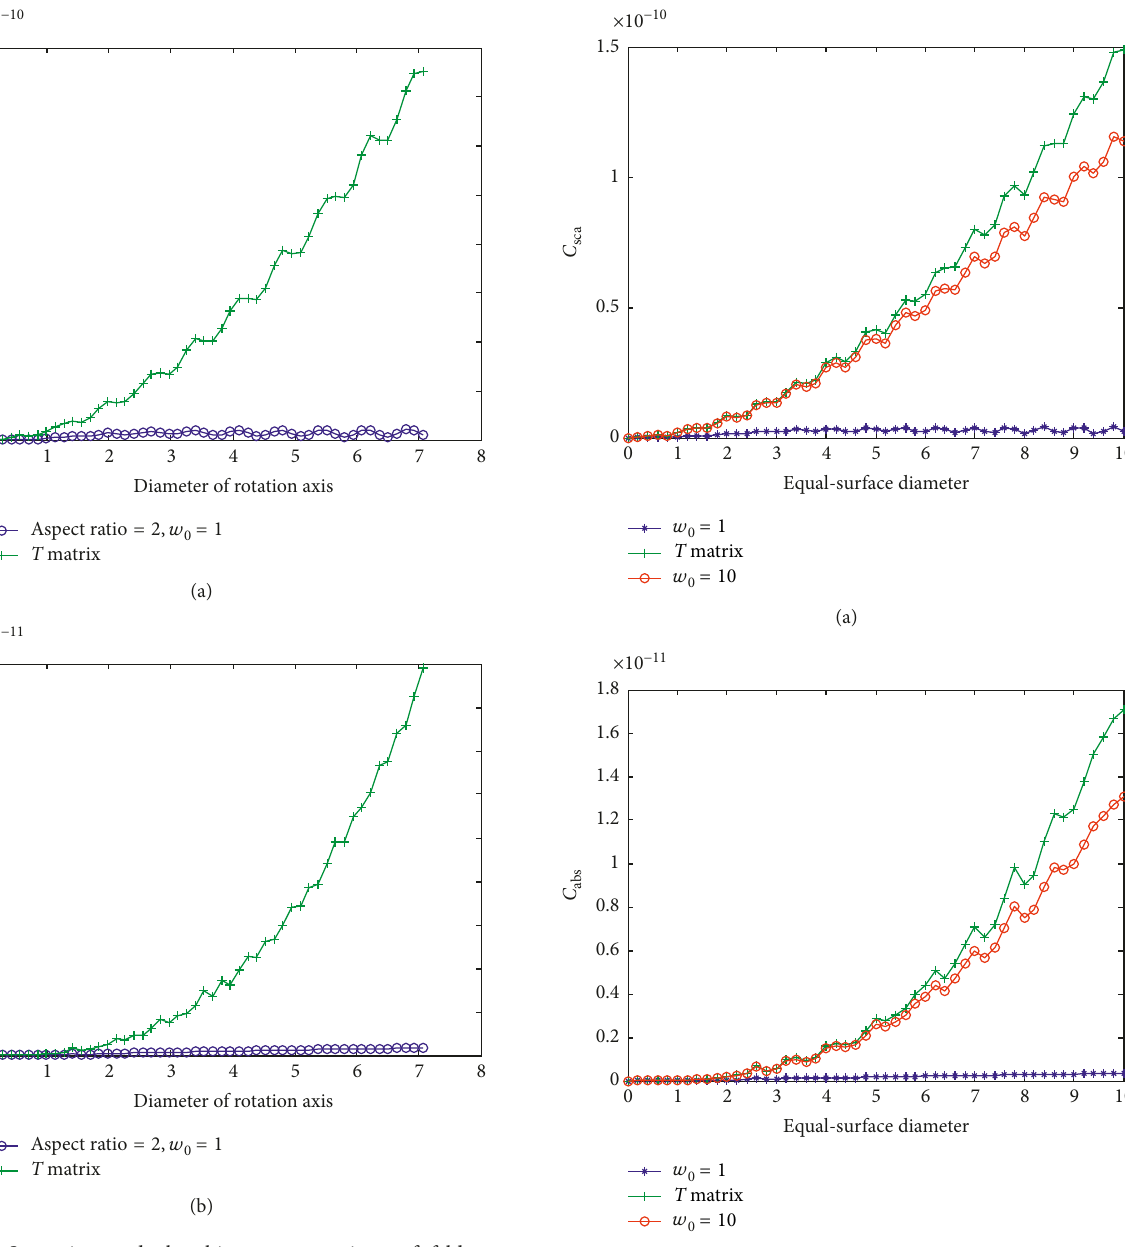
2, λ 0.5, m 1.5 +0.001 i ). (cid:31) (cid:31) (cid:31)